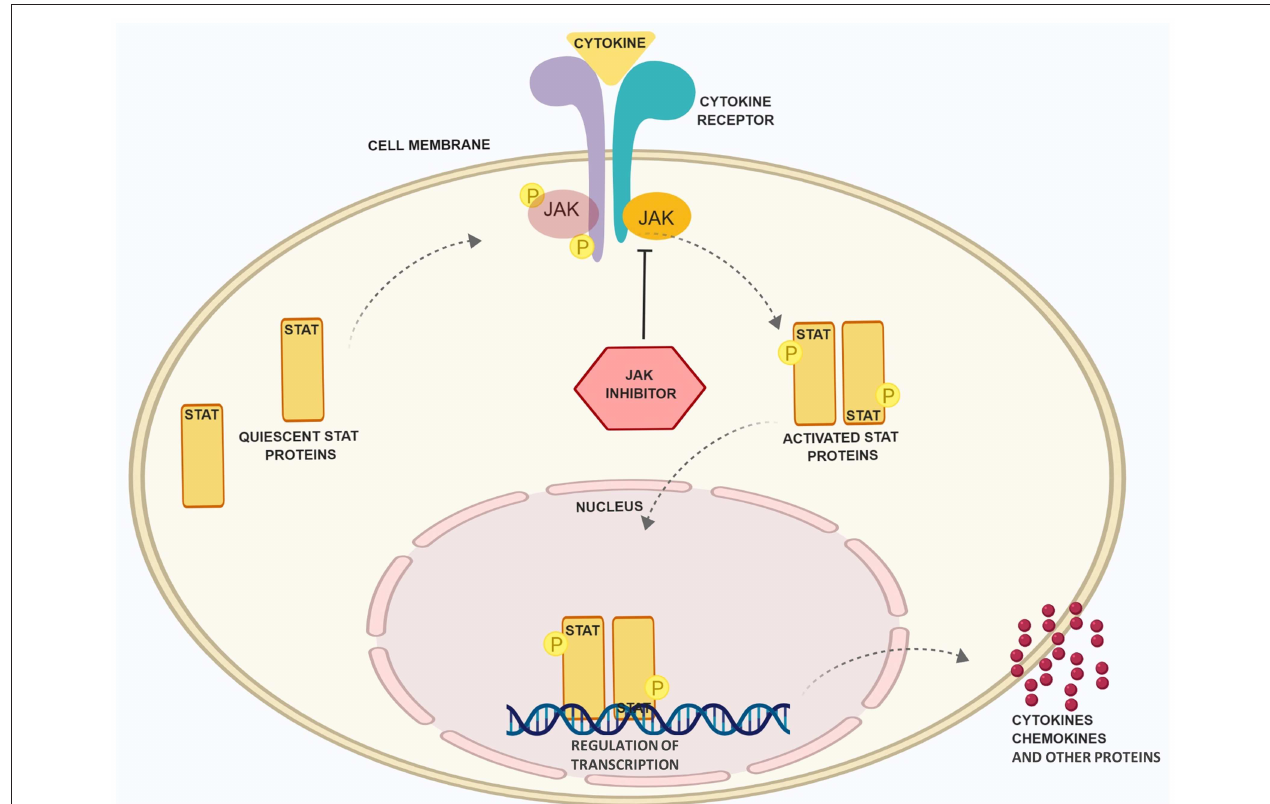
FIGURE 1 | Schematic presentation of the JAK/STAT pathway and the role of JAK inhibitory drugs. Binding of cytokines to receptors, which rely on the JAK/STAT pathway for signal transduction, leads to phosphorylation of JAK and STAT proteins. The latter dimerize, translocate into the nucleus and regulate the expression of inflammatory factors. JAK inhibitors (JAKi) prevent JAK phsophorylation and STAT activation. Figure was created with the help of